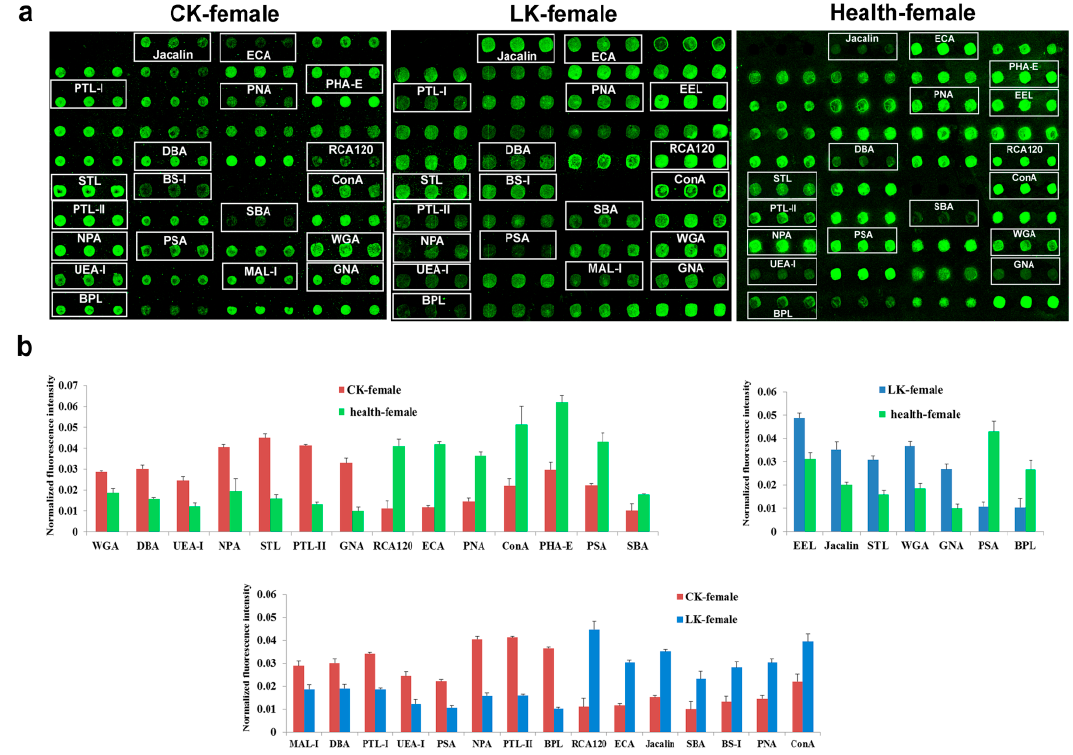
Figure 4. Female serum glycoprotein glycosylation patterns were determined by the binding of Cy3-labeled protein to 37 different lectins using a lectin microarray. CK: CKD, LK: LKD and Health: normal control. ( a ) Profiles of Cy3-labeled serous proteins from patients with CKD, and LKD, and normal individuals bound to the lectin microarrays. The lectin microarrays revealed lectins that exhibited significant differences, which are marked with white frames; ( b ) Significant differences in the lectin levels among the three groups. The bars represent mean + SD of the three biological replicates from each group.